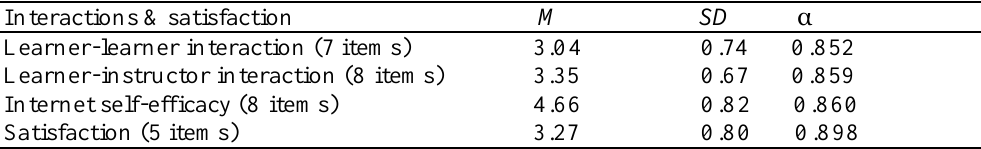
Descriptive Information of the Scales Interactions & satisfaction M SD α Learner-learner interaction (7 items) 3.04 0.74 0.852 Learner-instructor interaction (8 items) 3.35 0.67 0.859 Internet self-efficacy (8 items) 4.66 0.82 0.860 Satisfaction (5 items) 3.27 0.80